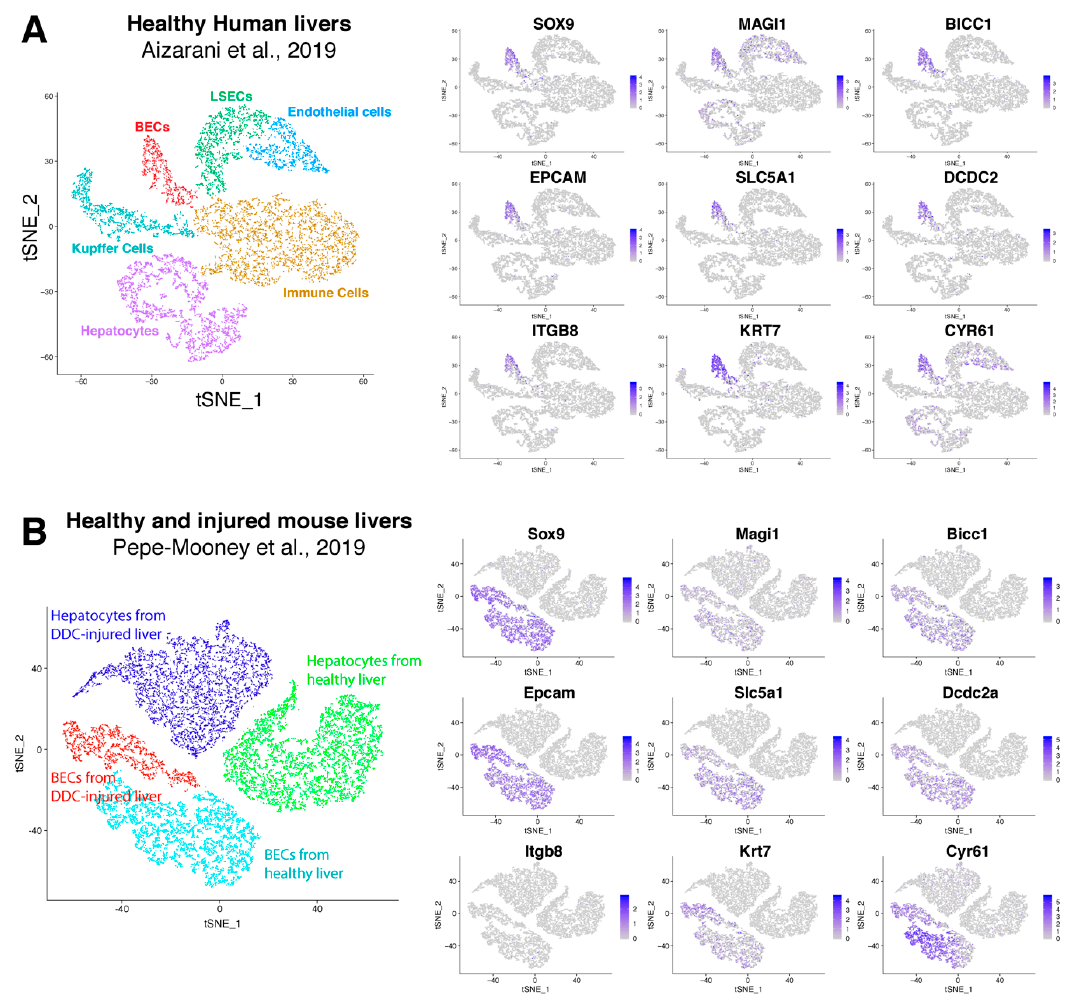
Figure 7. Validation of scBEC signature. TSNE plots of human ( A ) and mouse ( B ) liver cells from respectively Aizarani et al. 2019 [28] and Pepe-Mooney et al. 2019 [27], with expression of every single gene of the scBEC signature. Blue scale bars represent normalized counts.